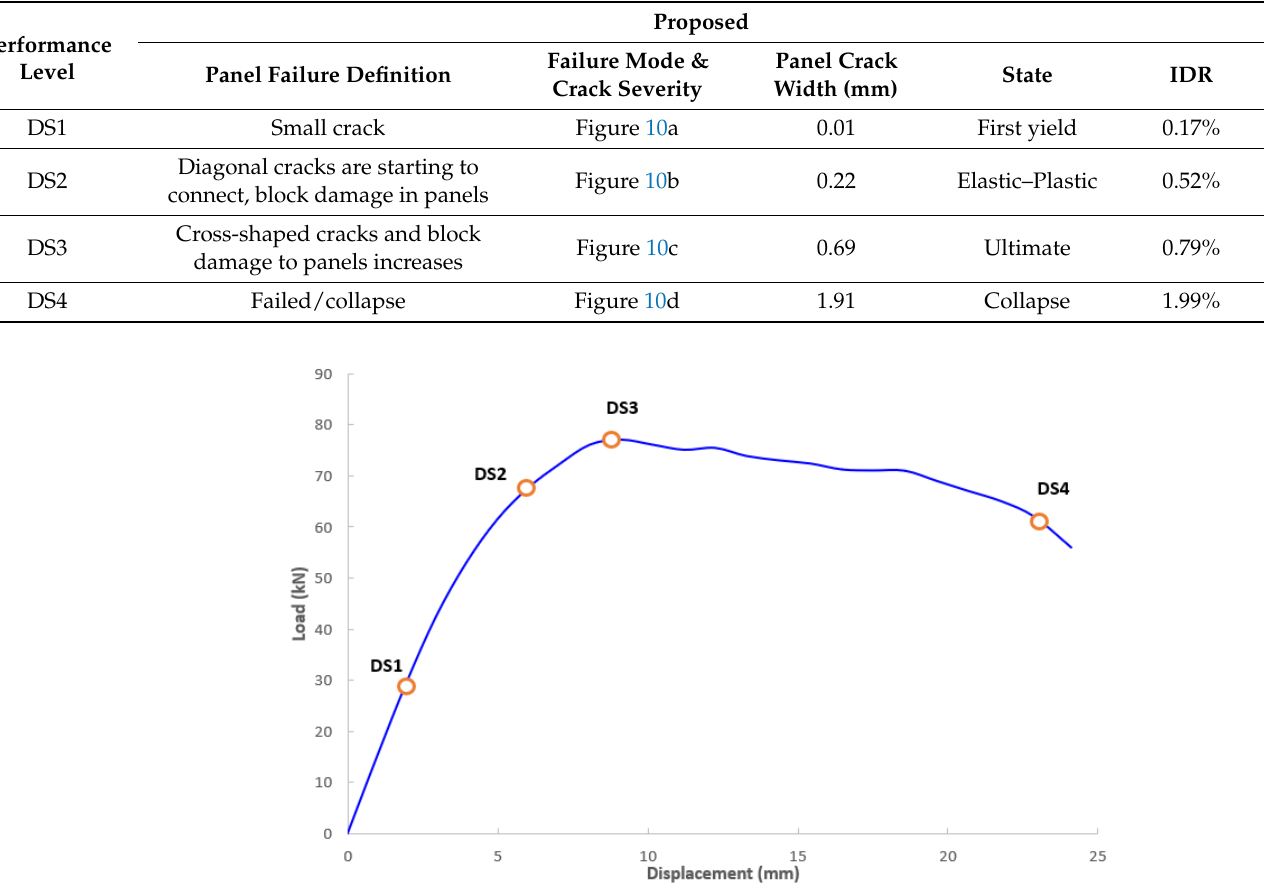
Figure 11. Damage states infilled frame based on the proposed IDR initiated through the local damage panel.